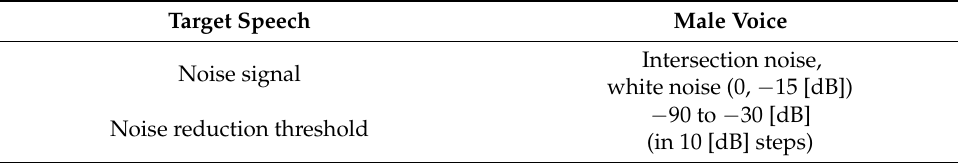
Intersection noise, white noise (0, − 15 [dB]) − 90 to − 30 [dB] (in 10 [dB]